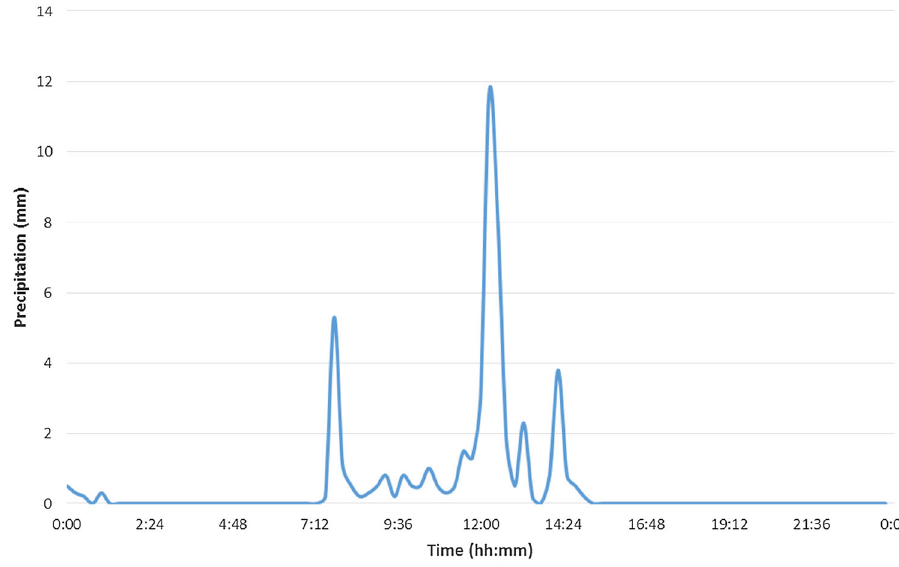
Fig. 5 Hydrograph of the